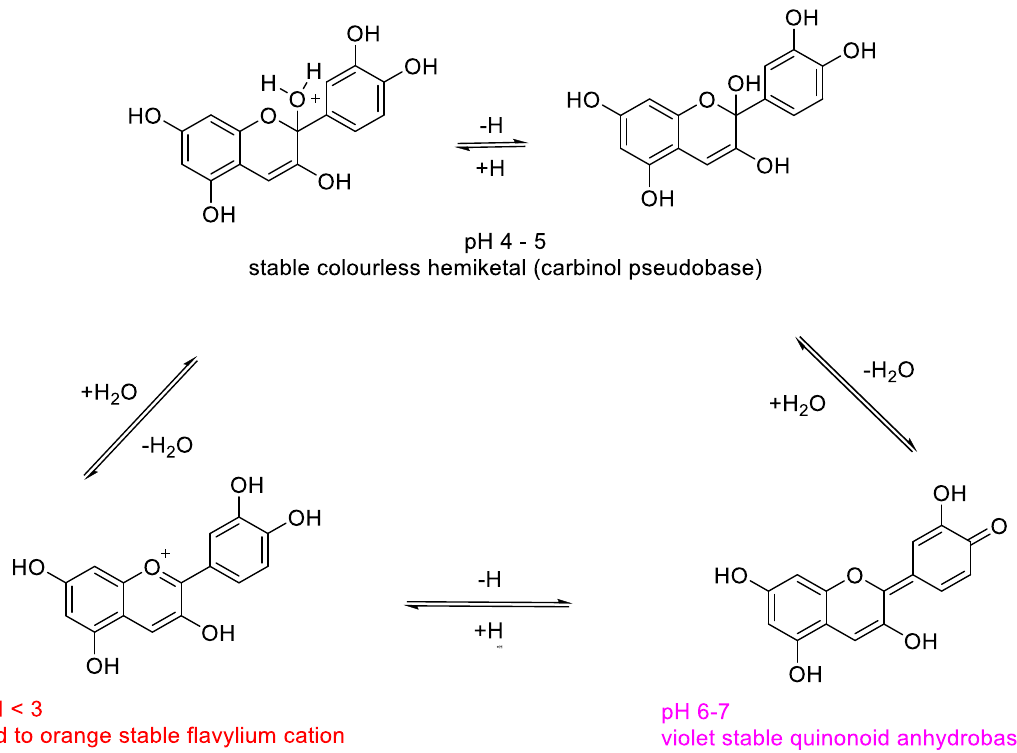
Figure 7. Stable colored and colorless forms of cyanidin at different pH values.